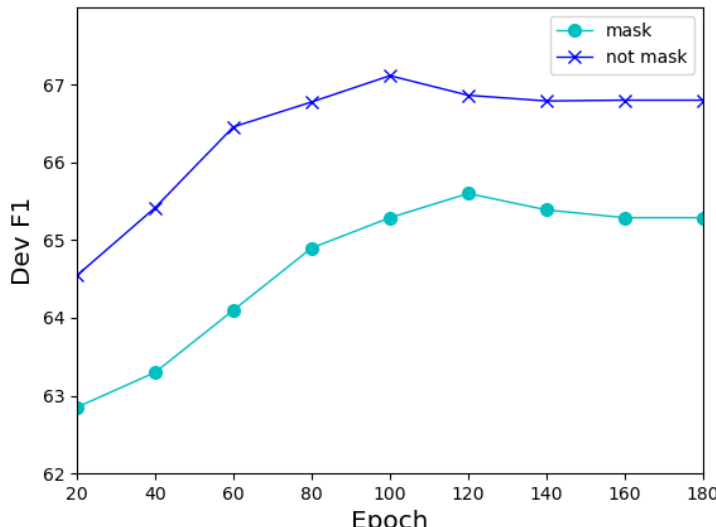
Figure 4. Experimental results in terms of F1 under different epochs with and without masking the